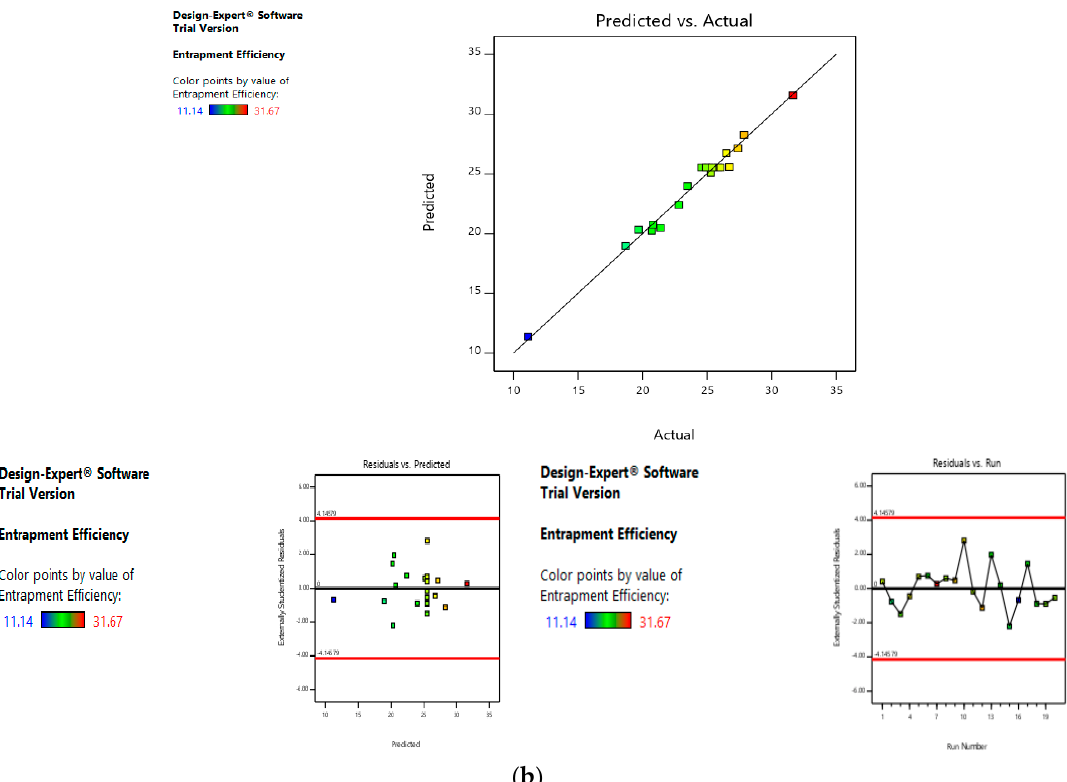
Figure 4. Risk assessment (first level) ( a ) with respect to size. ( b ) with respect to entrapment efficiency.